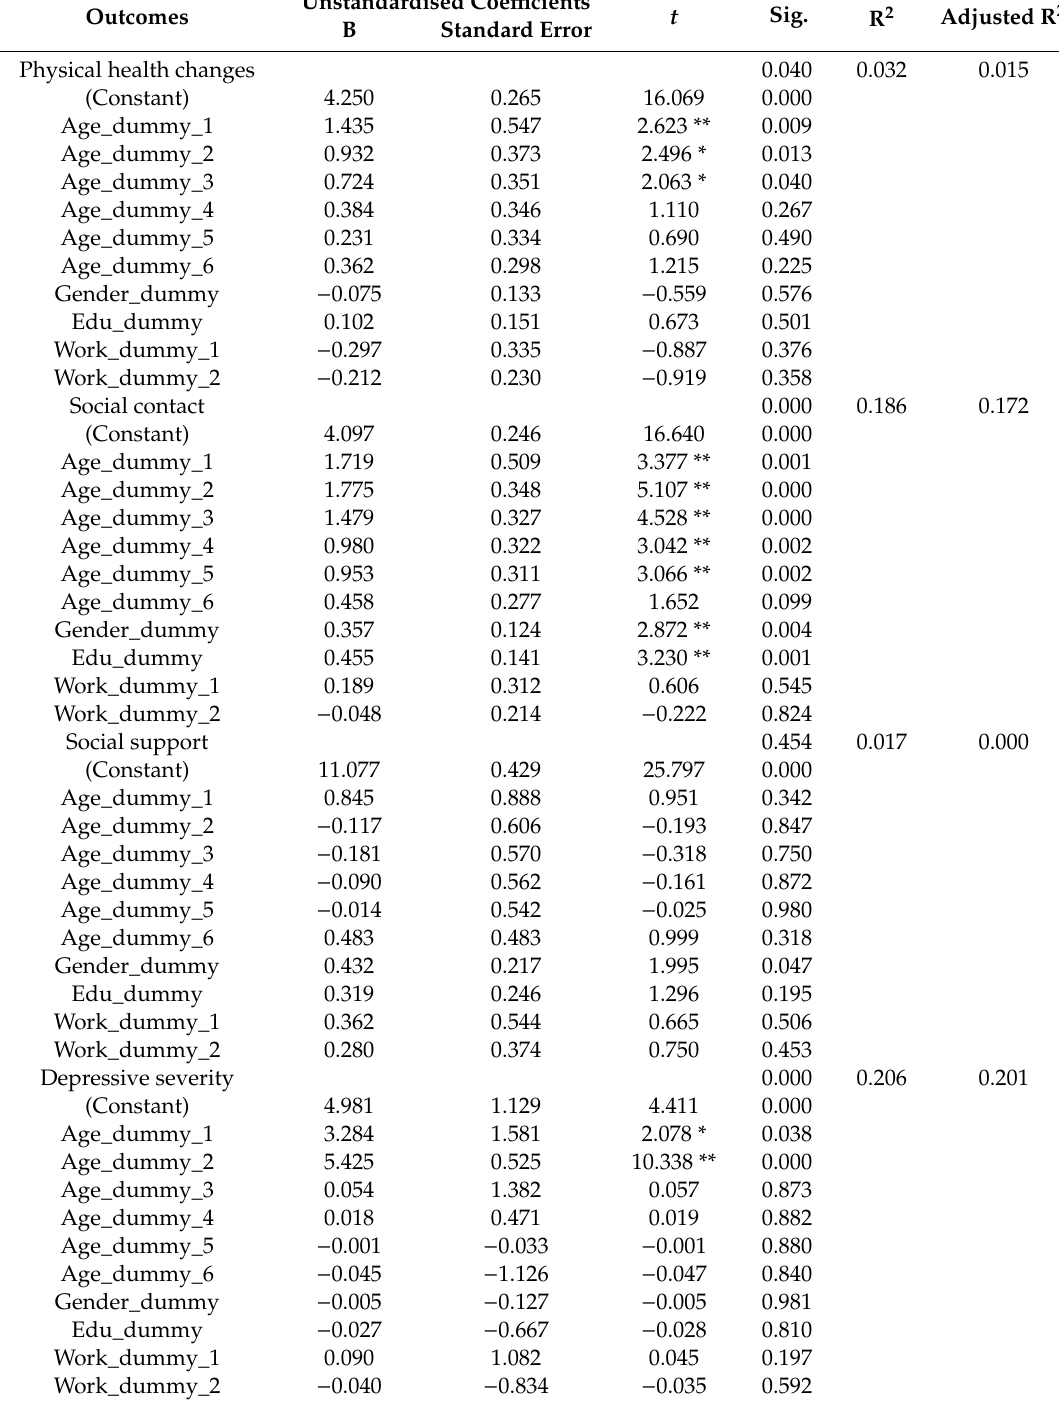
Table 3. Regression model for predicting physical health changes, social contact, social support and depressive